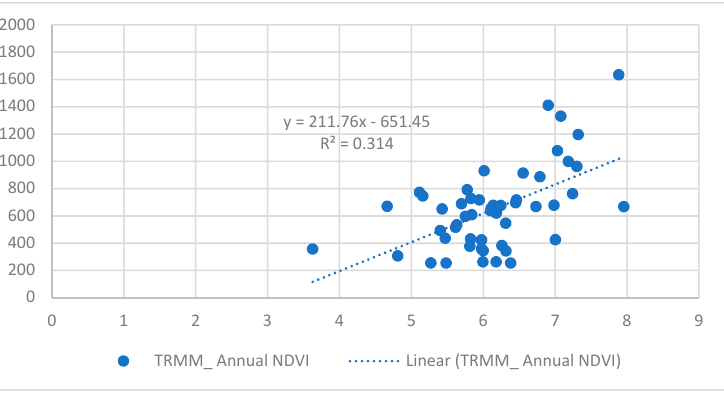
Figure 1. Relationship between NDVI and